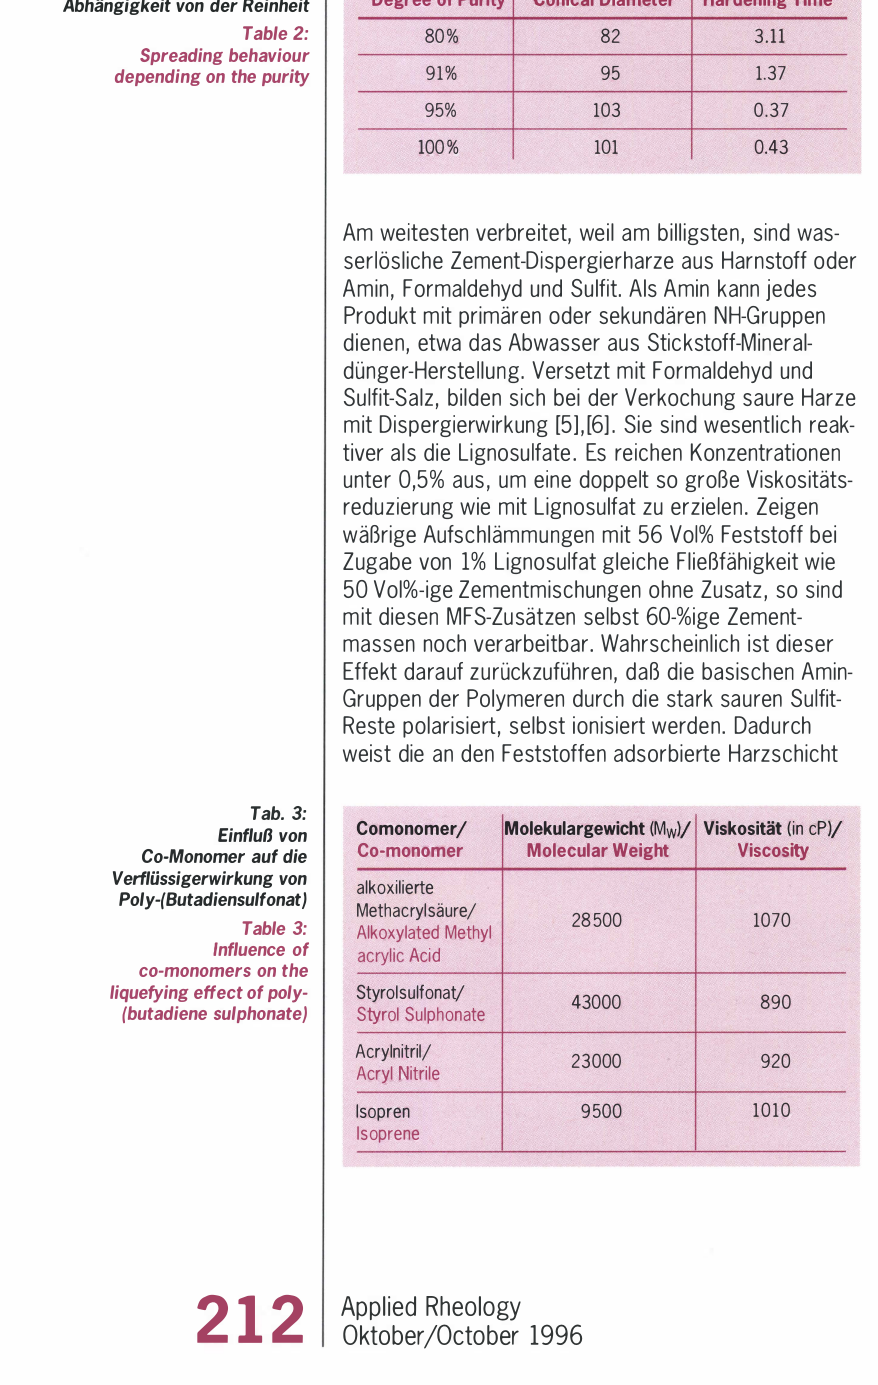
Tab. 2: Ausbreitungsverhalten in Abhangigkeit von der Reinheit Table 2: Spreading behaviour depending on the purity